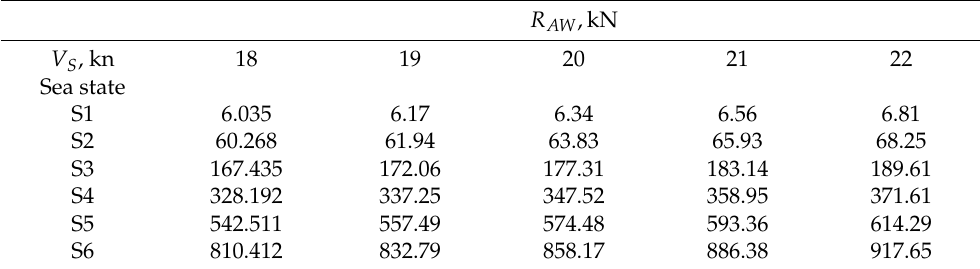
Table 4. Added resistance in waves for various ship speeds and sea states.